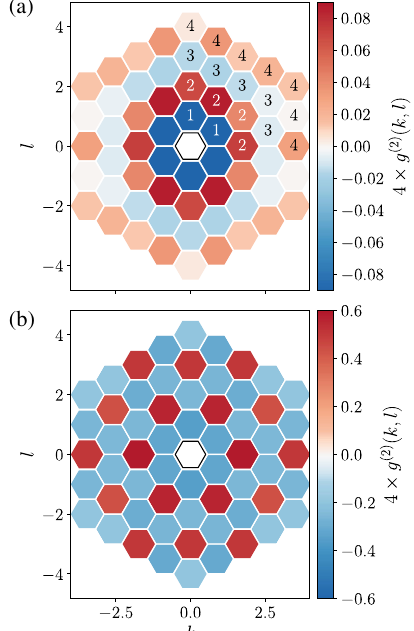
FIG. 12. Correlations on the N ¼ 36 -site triangular array (only the first four Manhattan shells are shown). (a) Experimentally measured correlations after a sweep on the triangular array featuring a pronounced Manhattan shell structure g ð 2 Þ ð k; l Þ ∝ ð − 1 Þ m . The numbers give the value of m ¼ j k j þ j l j . (b) Corre- lations of the equal superposition of the classical ground states for k δ as reached at the end of the sweep used in (a). These final correlations are in qualitative agreement with the correlations expected in the 1 = 3 AF state in the right panel of Fig.